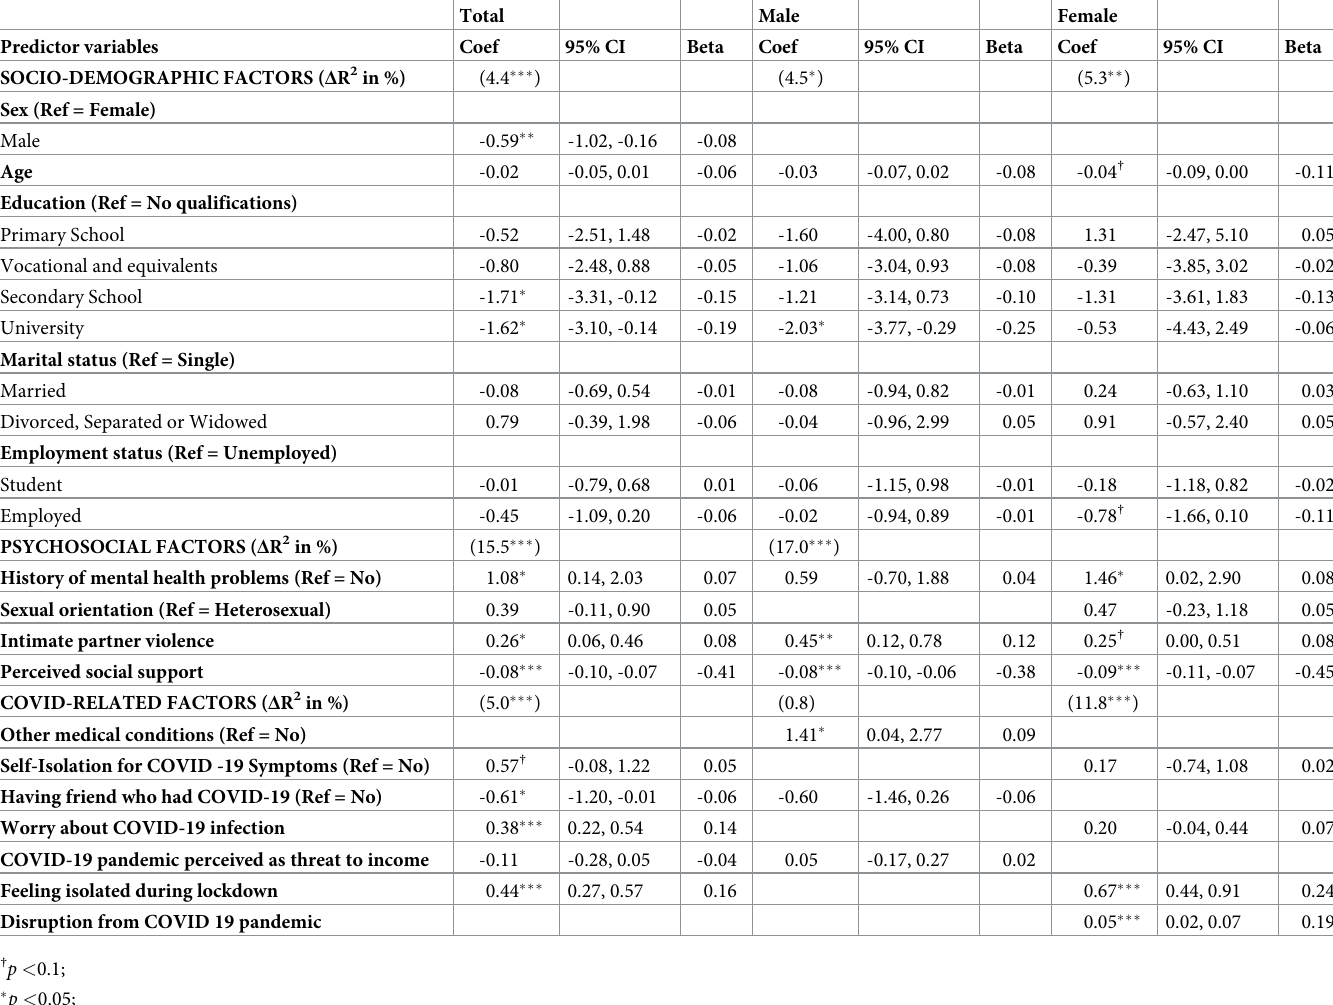
Table 5. Multivariate associations between depressive symptoms and predictors with sex